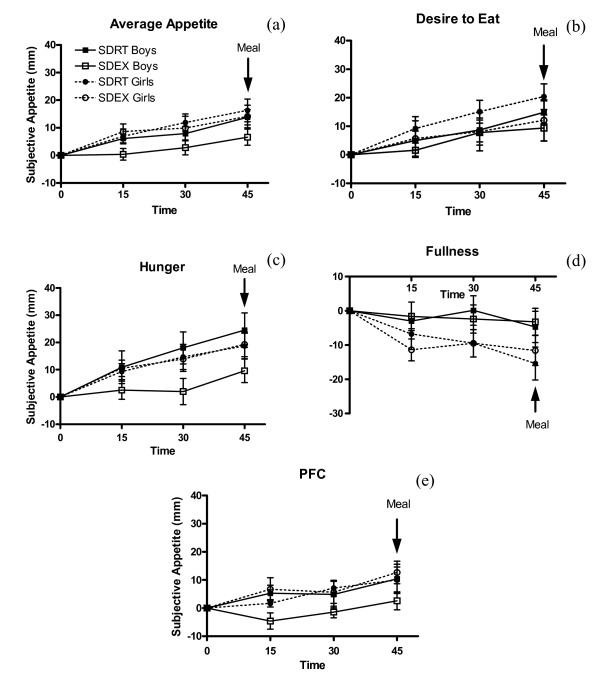
Effect of short-duration exercise at the VeT on subjective appetite scores. 1Average appetite (a) desire to eat (b) hunger (c) fullness (d) PFC (e) at 15, 30, and 45 min during short-duration sessions. 2SDRT = short-duration rest, SDEX = short-duration exercise, PFC = prospective food consumption. 3Change from baseline appetite scores increased with time for average appetite (p = 0.0005), desire to eat (p = 0.011), hunger (p = 0.0027), and PFC (p = 0.0047), and subjective fullness decreased (p < 0.0001). SDEX attenuated the increase in average appetite (p = 0.027), desire to eat (p = 0.049), and hunger (p = 0.0072) when compared with SDRT, but did not affect fullness (p = 0.98) or PFC (p = 0.15). Sex was not a factor on change from baseline average appetite (p = 0.11), desire to eat (p = 0.41), hunger (p = 0.46), fullness (p = 0.81), or PFC (p = 0.22). However, there was a significant treatment × sex interaction on PFC (p = 0.013). 4Test meal began at 45 min.